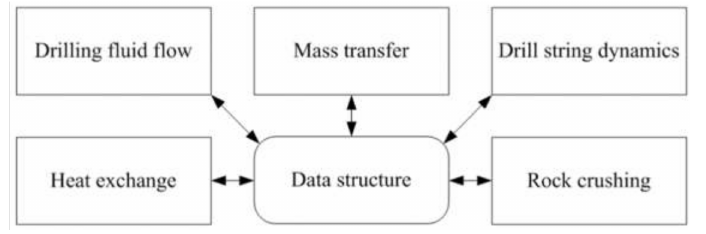
Figure 4. The combined model